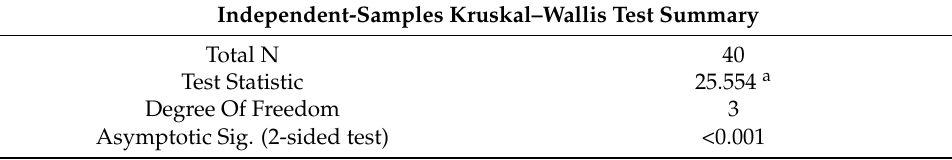
Table 3. Kruskal–Wallis Test